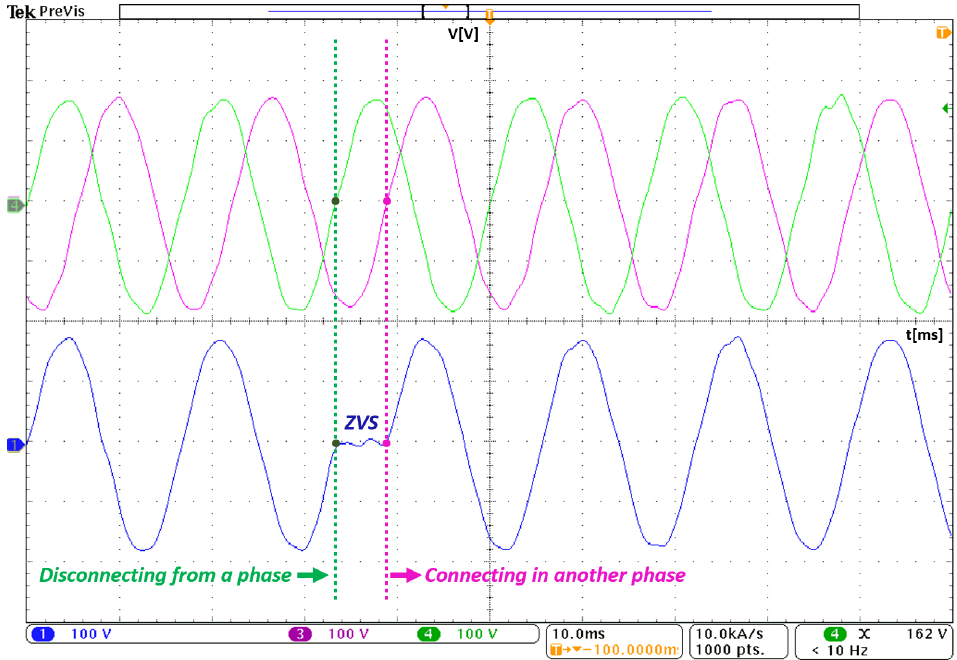
Figure 15. Switching process between phases at the voltage zero